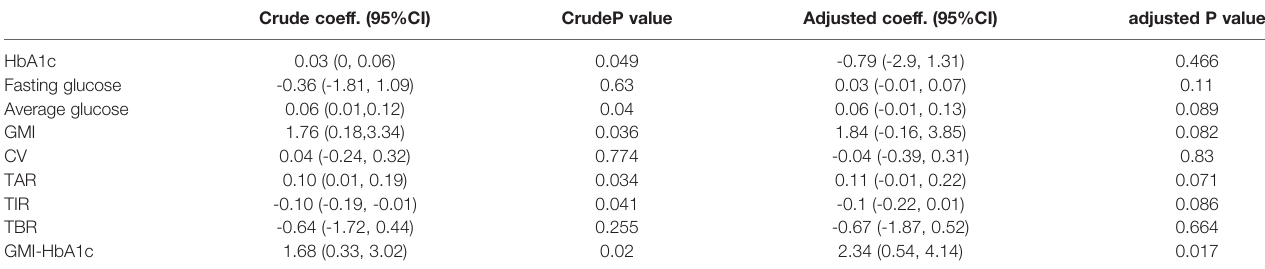
TABLE 4 | Effect of CGM metrics on ICU stay.